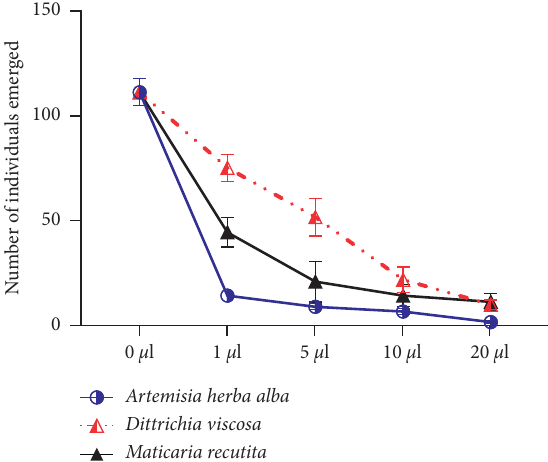
Figure 13: Effects of essential oils on the number of individuals emerging after the completion of life cycle.